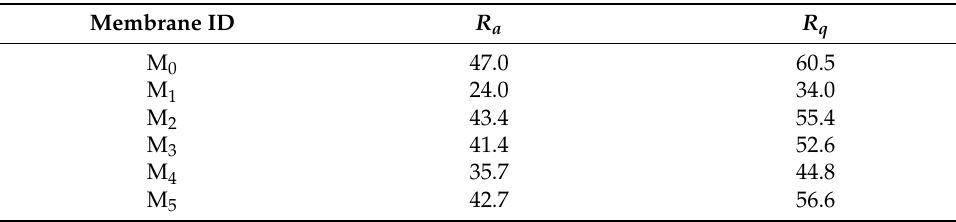
Table 2. Surface roughness data of pristine and composite membranes.